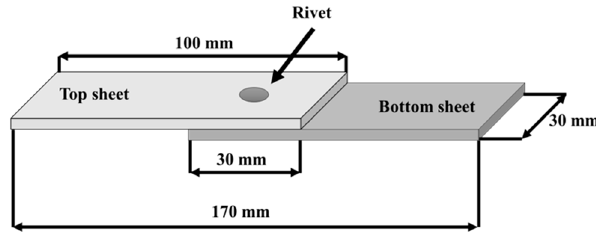
Figure 5. Schematic diagram of tensile–shear test specimen (KS B ISO 14273).